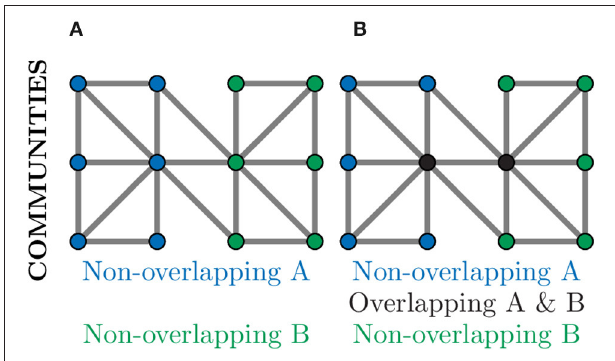
FIGURE 9 | Community detection provides global clustering that can be either non-overlapping or overlapping depending on the algorithm used. (A) Non-overlapping communities assign each node to a community (blue or green) based on the choice of metric, often relating to number of connections. Such community detection algorithms could identify physical regions of the brain. (B) Over-lapping communities can assign a node to more than one community (black nodes) if they contribute to multiple communities. Such community detection algorithms could identify communication pathways through a